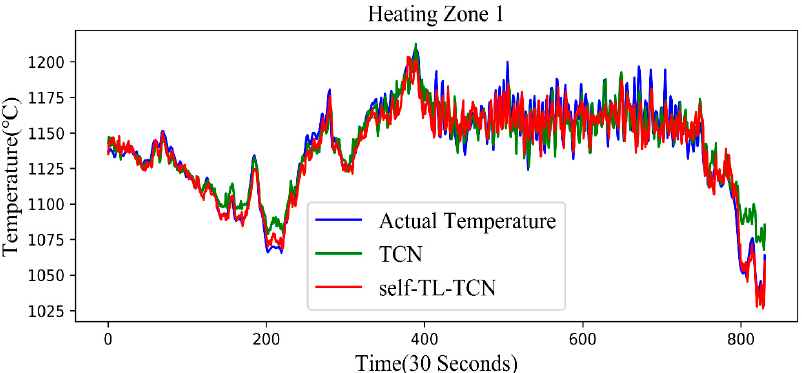
Figure 12. Prediction results before and after TCN optimization. Sensors 2020 , 20 , x FOR PEER REVIEW